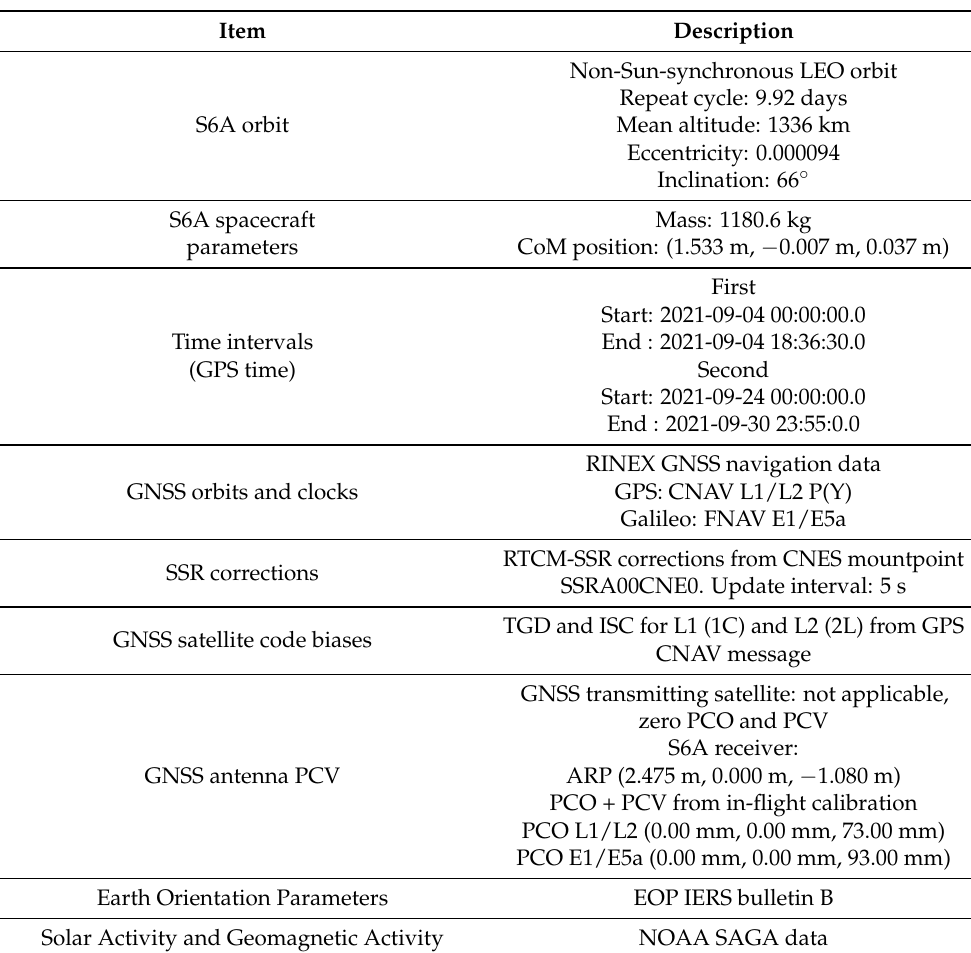
Table 1. Dataset processed in this work, including satellite data, measurements, GNSS ephemerides, and antenna and SSR